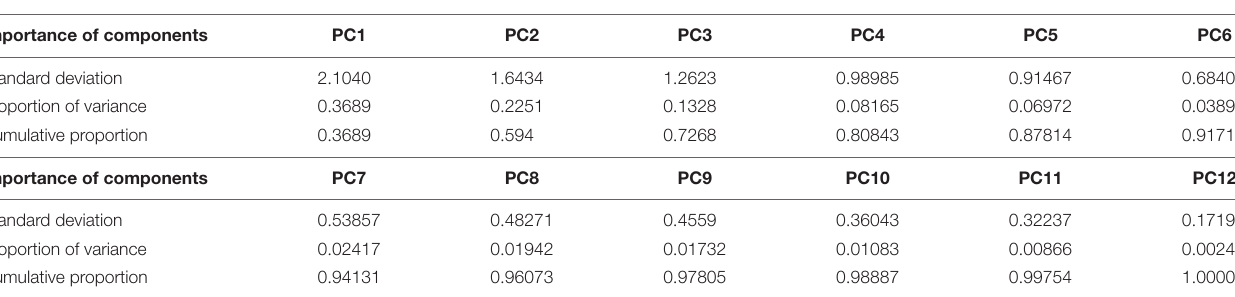
TABLE 3 | PCA components